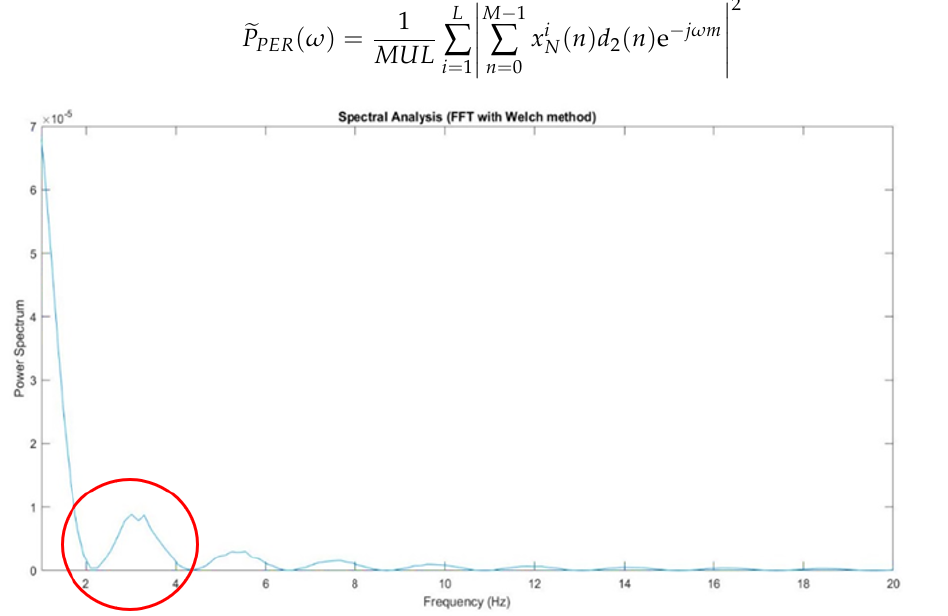
Figure 8. Fourier transformation with Welch method; the maximum spectral response is about 2~4 Hz.